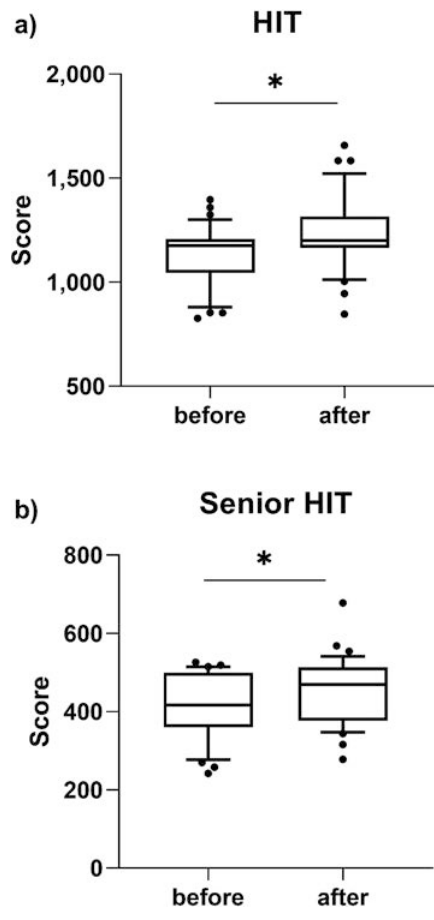
Figure 2 Level of understanding before and after training. a) Questions based on Healthcare Information Technologist: Specific Behavioral Objectives (2016). b) Questions based on Senior Health Information Technologist: Specific Behavioral Objectives ver. 1.1